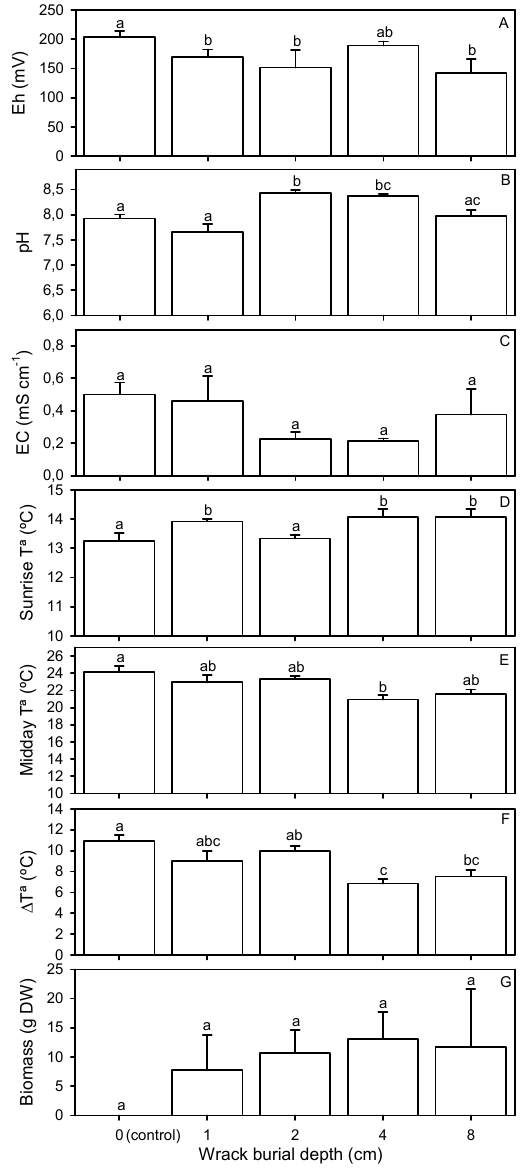
Figure 1. Substrate ( A ) redox potential (Eh), ( B ) pH, ( C ) electrical conductivity (EC), temperature at ( D ) sunrise and ( E ) midday, and ( F ) the difference ( ∆ ) between midday and sunrise temperatures, and ( G ) biomass (in dry weight, DW) of plant species other than Iris pseudacorus in the five wrack burial treatments. Values are mean ± SE. Different small letters over the columns indicate significant differences among treatments (LM or GLM, p < 0.05).